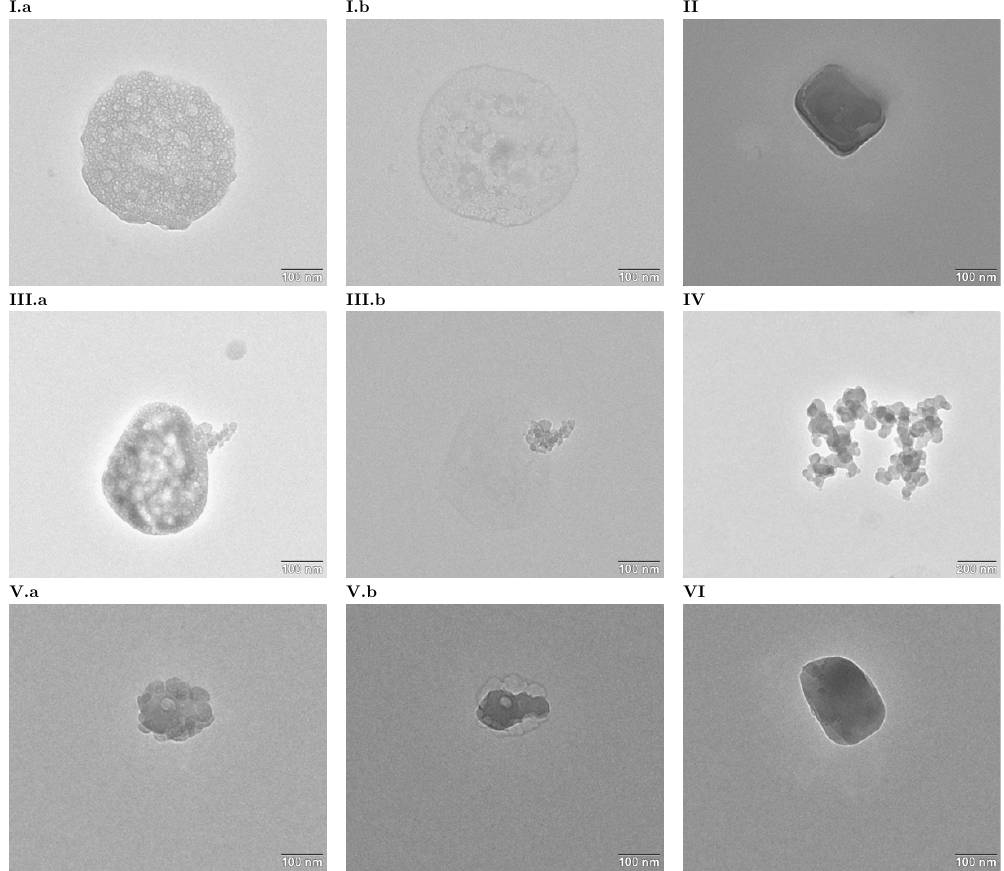
Figure 5. Transmission electron microscope bright field images of collected aerosol particles. Panels (I.a, b, III.a, b, V.a, b) are before and after evaporation of non-refractory material respectively. For (II) , (IV) and (VI) no significant evaporation was observed. (I) An example of a non-refractory particle. (II) Sea-salt particle. (III) A non-refractory particle with a small soot particle adhering to the surface. (IV) A soot particle. (V) Refractory particle with significant amounts of sodium and potassium. (VI) A dust particle. The bar in the lower right corner of each image represents 100nm, with the exception of (IV) , where it represents